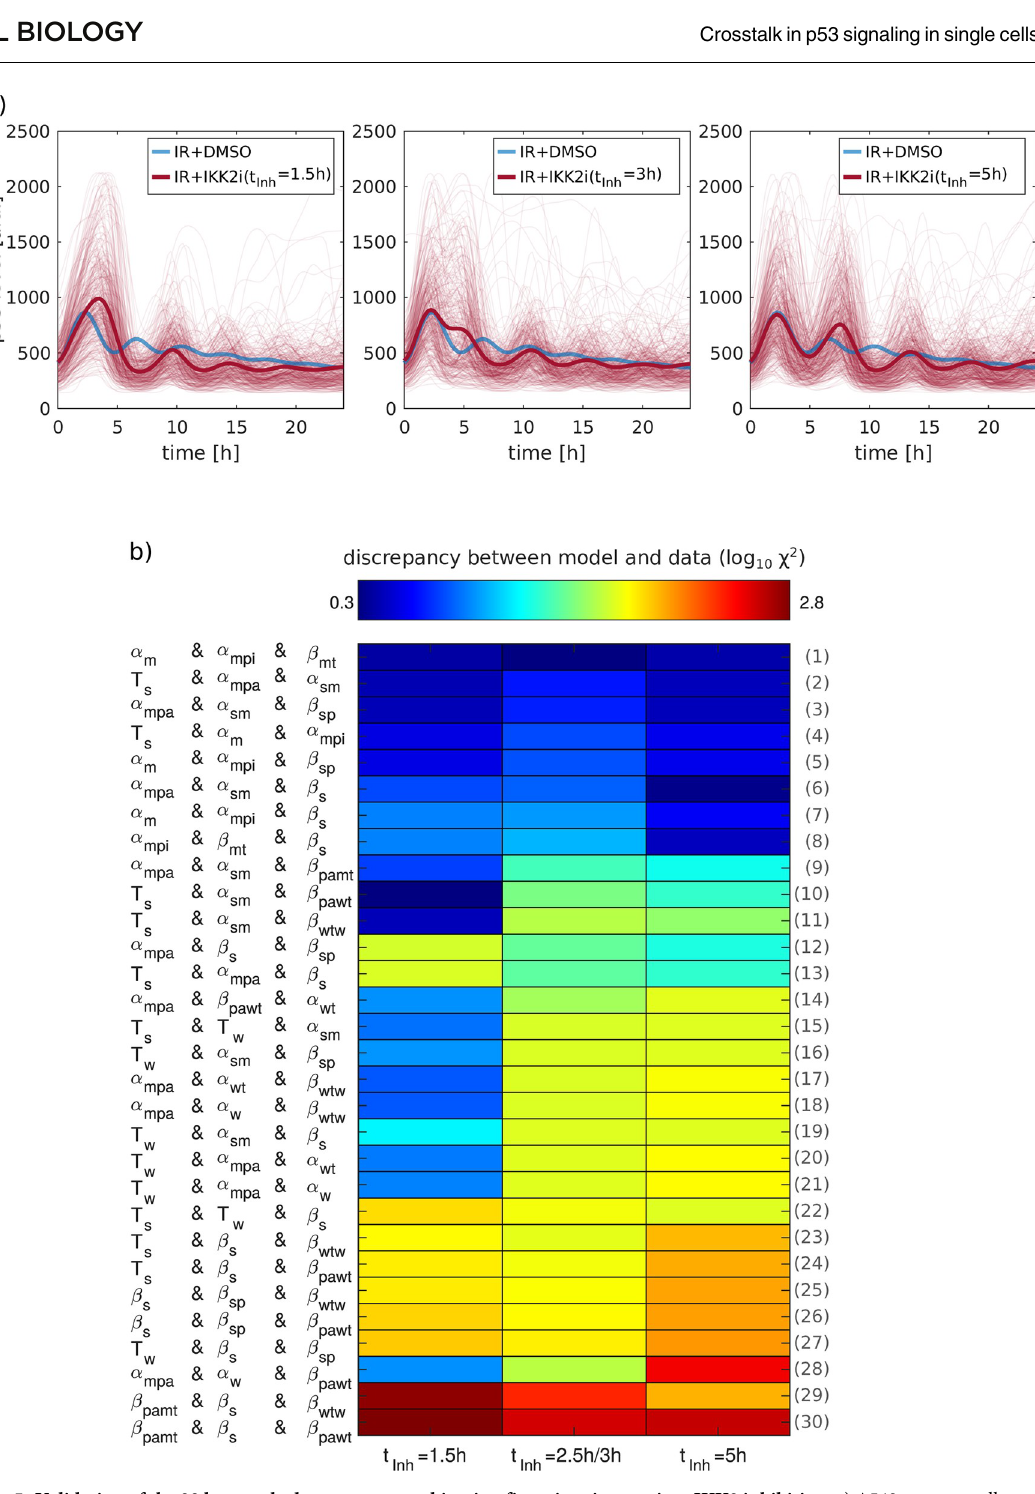
Fig 5. Validation of the 30 best ranked parameter combination fits using time-variant IKK2 inhibition. a) A549 reporter cells were tracked and the p53 median nuclear fluorescence intensity was measured in cells treated with DMSO or IKK2i at different time points. Sample trajectories are shown in which IKK2 was inhibited at the indicated time points. In an additional experiment, IKK2 was inhibited at 1.5h, 2.5h and 5h after IR. b) Each box depicts the color coded log 10 χ 2 value for model simulations with individual parameter combinations and time points of IKK2 inhibition. For better visualization, the plotted log 10 χ 2 value summarizes the values of two data sets with similar time points of IKK2 inhibition (1.5h/1.5h, 2.5h/3h, 5h/5h). The inhibitor was applied at accumulating levels of p53, resulting in the first peak (t Inh = 1.5h), decreasing p53 levels (t Inh = 2.5h and t Inh = 3h) as well as at the accumulation resulting in the second peak (t Inh = 5h). The parameter combinations are sorted based on the corresponding summarized log 10 χ 2 value. Indices of the parameter combinations are given by the numbers on the right hand side of the